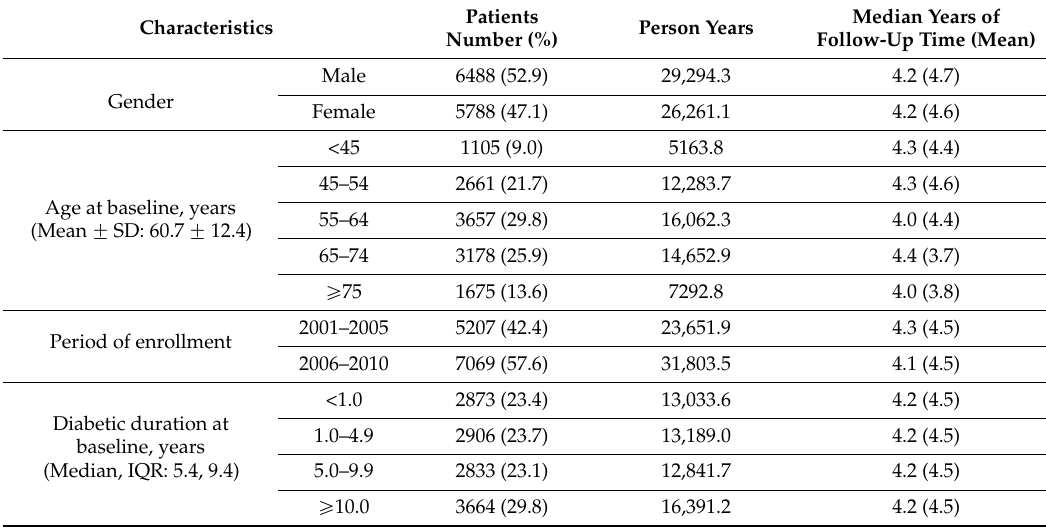
Table 2. Follow-up time of the T2DM